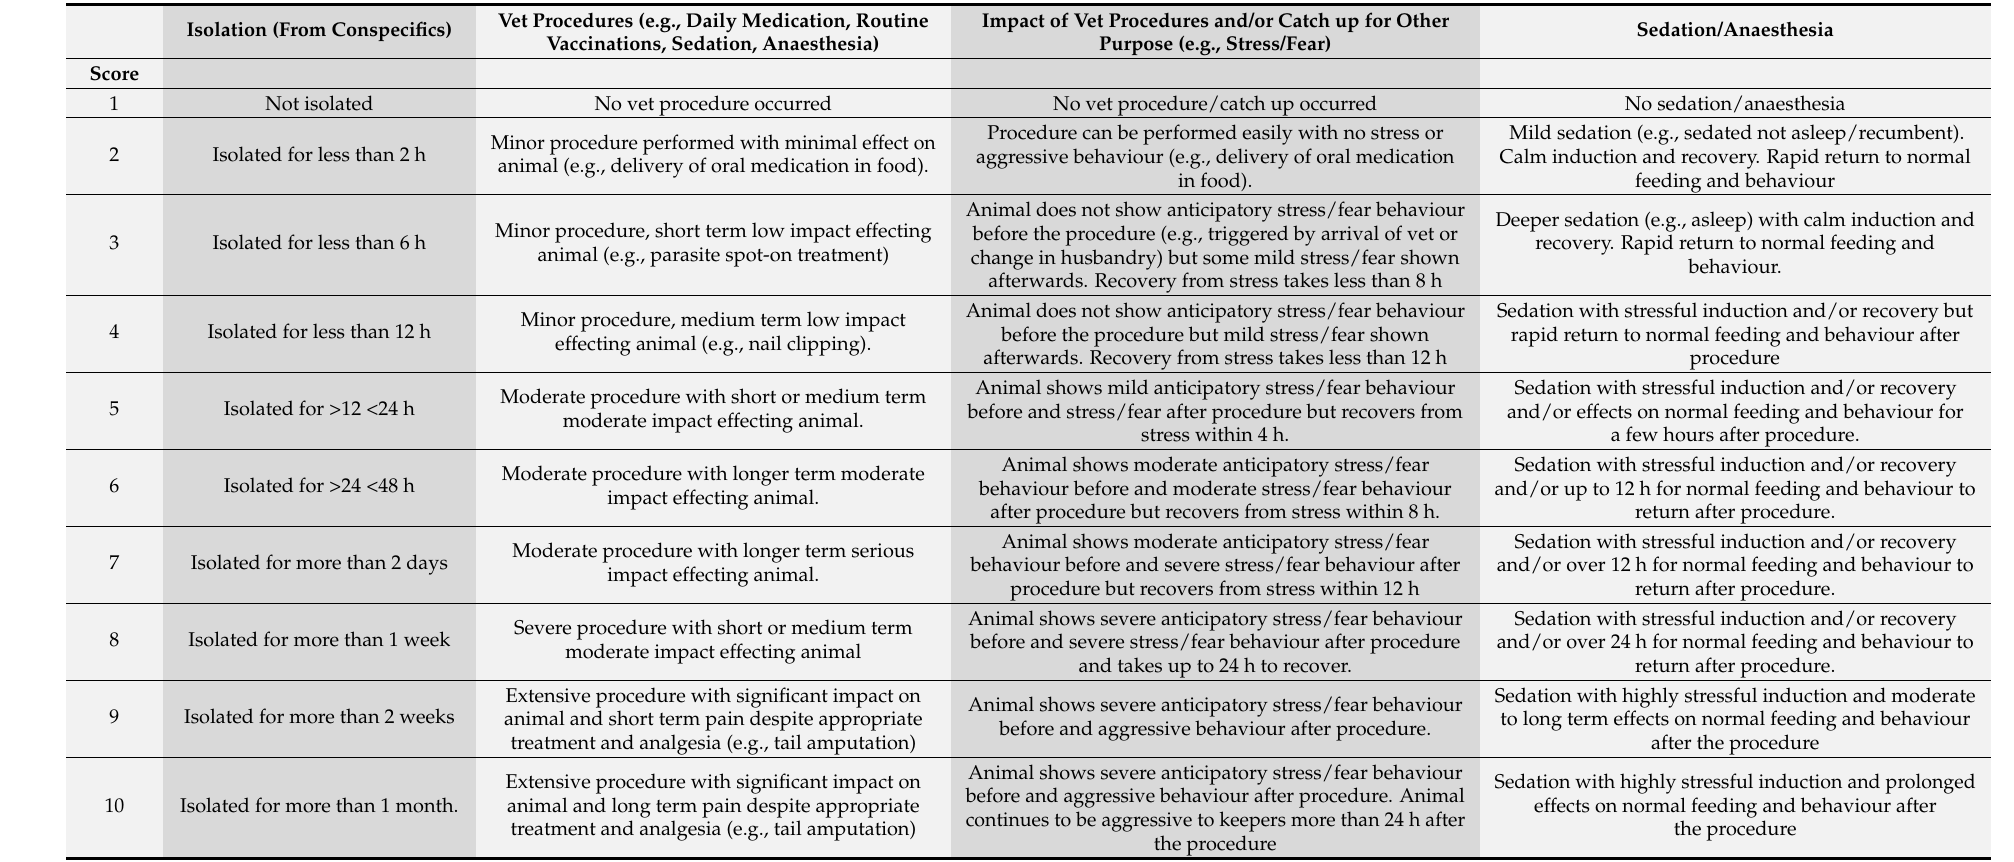
Table 4. Factors scored within the procedural